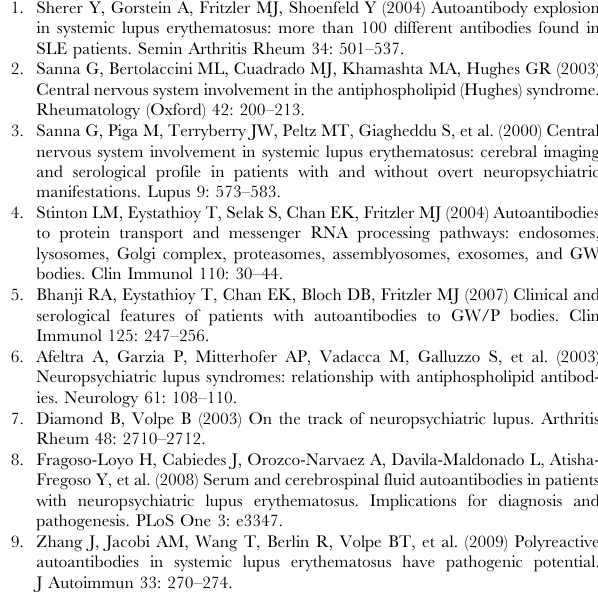
Figure S1 Screening anti-neuronal aAbs in the sera/CSF of NPSLE and SLE control patients by indirect immunofluorescence. NPSLE serum from a patients with severe cerebralitis and myelitis was identified by its reactivity to all species. All sera/CSF of SLE probes are ANA positive without cytoplasmic staining against Hep2 cells, and neither have anti-ribsomal P antibodies. Scale bar = 50 m m. Figure S2 An experimental group (INA immunized, LPS- treated, n= 16) and two control groups (normal, n= 10 and INA immunized alone, n= 12) were studied. Neurological dysfunctions including exploratory behavior and motor coordination, was observed in INA + LPS mice in open field activity and beam walking